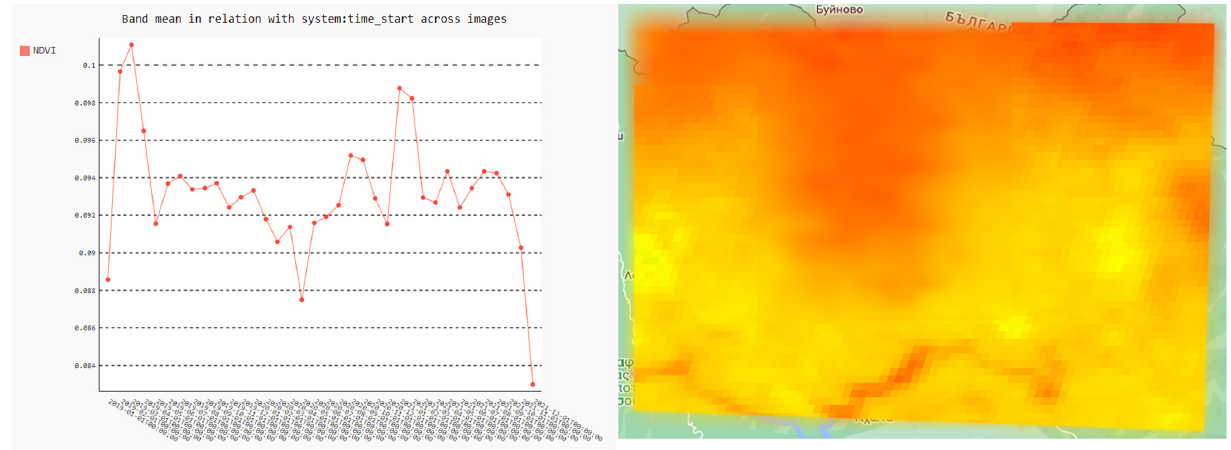
Figure 5. Median monthly NDVI values. Agriculture 2023 , 13 , x FOR PEER REVIEW